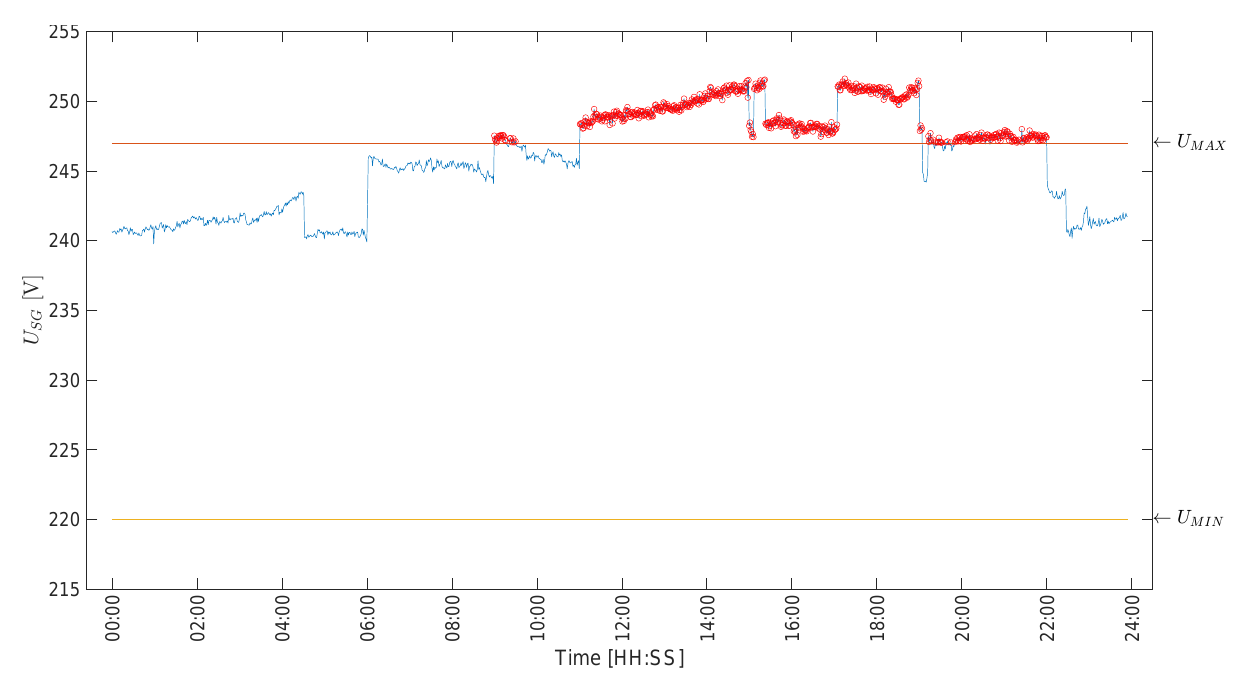
Figure 8. Examples of U values with marked threshold ranges U MIN and U MAX